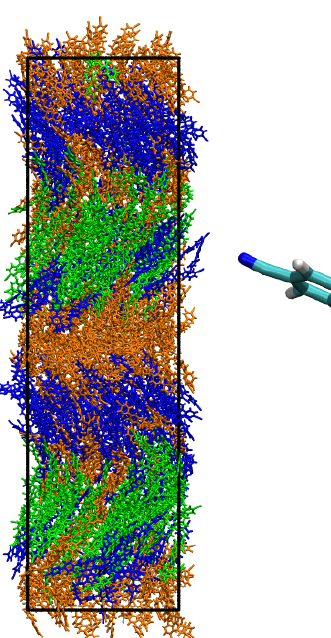
Figure 4. ( Left ): Snapshot, with orientational colour coding, showing the structure of the N TB phase of CB7CB. ( Right ): The structure of a CB7CB